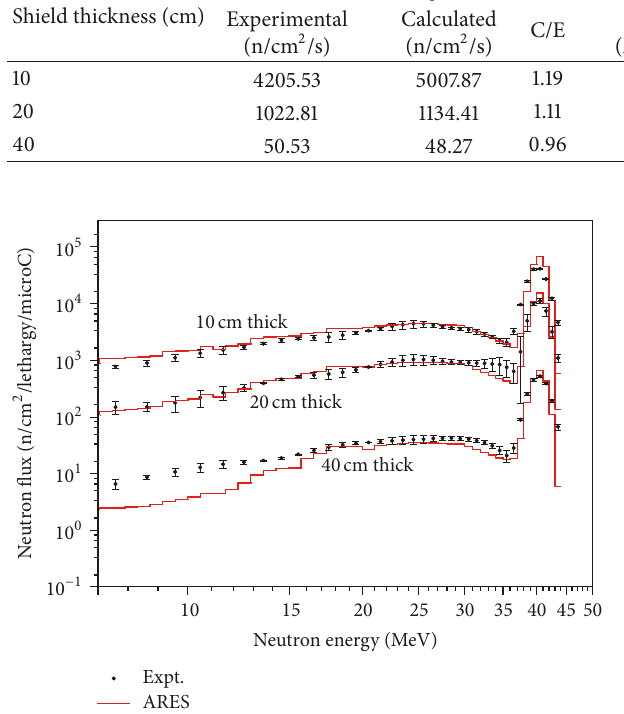
Table 2: The ratio of calculation to measurement in peak and continuum regions for iron shielding experiments. Shield thickness (cm)